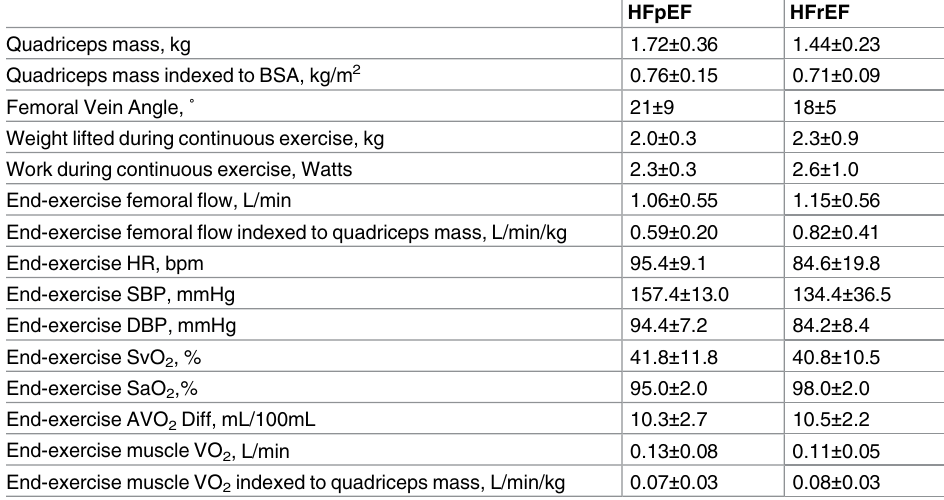
Table 2. MRI parameters obtained at rest and end of sub-maximal unilateral knee extensor exercise.